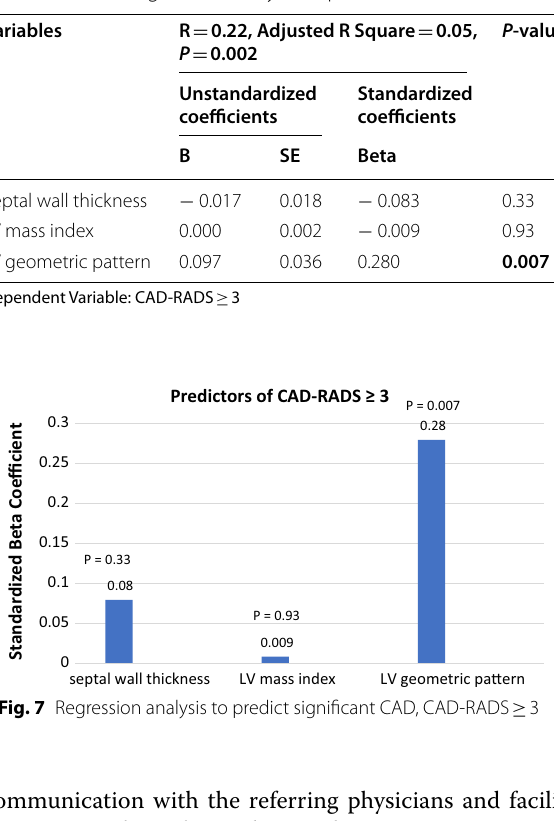
Table 8 Linear Regression Analysis to predict CAD-RADS